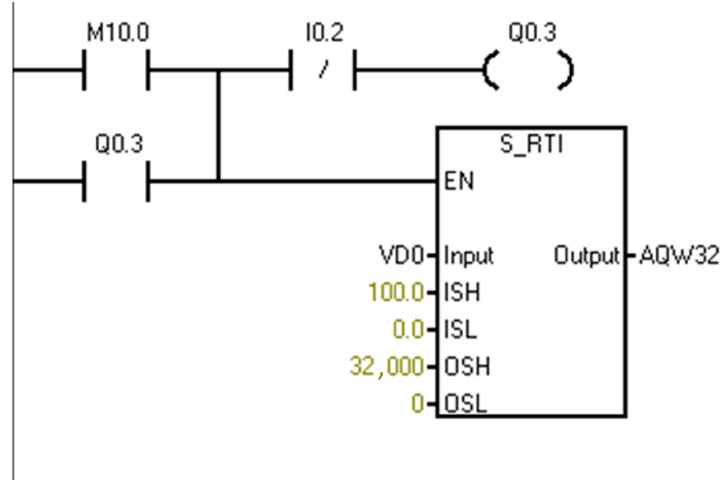
Figure 7. Vibratory feeder control program.